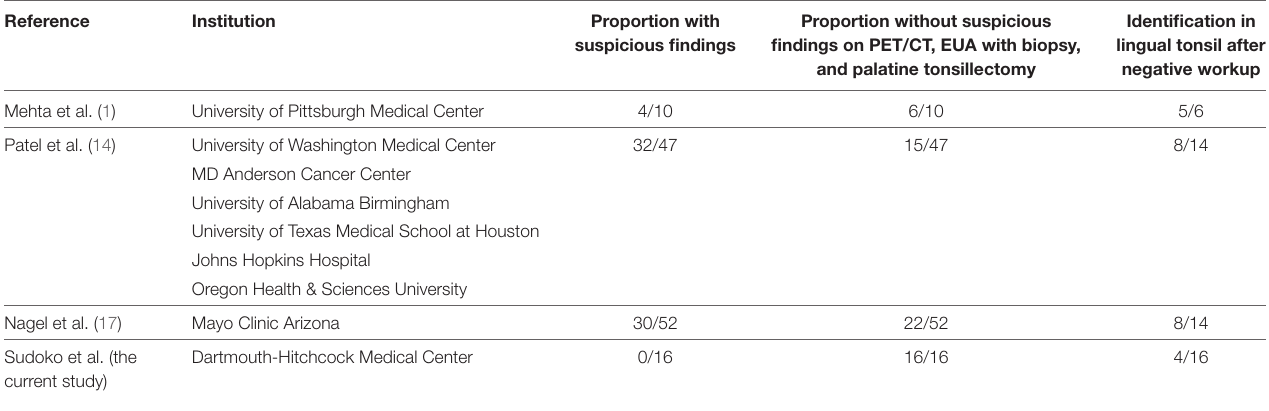
Table 4 | Proportion of patients without suspicious findings on diagnostic workup and identification in the lingual tonsil.